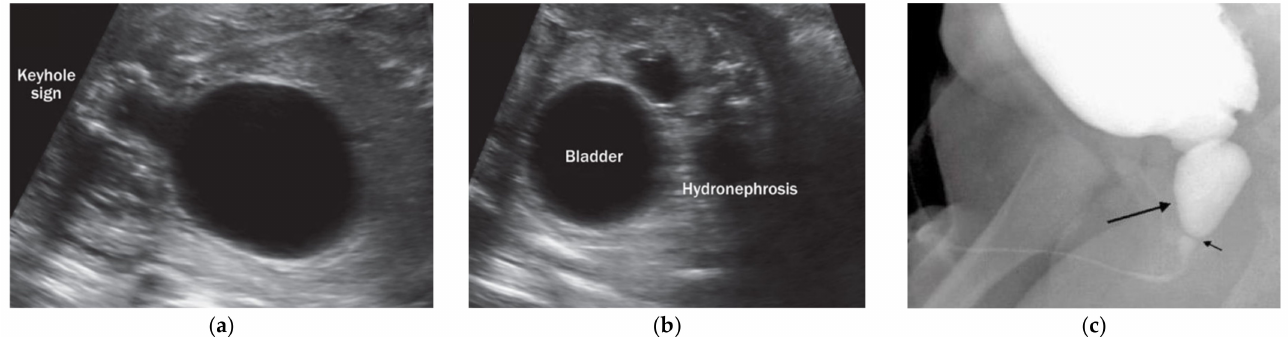
Figure 1. The phenotype of LUTO. ( a , b ) Prenatal fetal ultrasound with typical “keyhole sign” of the obstructed bladder with congenital LUTO; ( c ) postnatal VCUG (voiding cystourethrography) of a patient with congenital PUV (long arrow pointing at pre-stenotic urethra, short arrow pointing at urethral